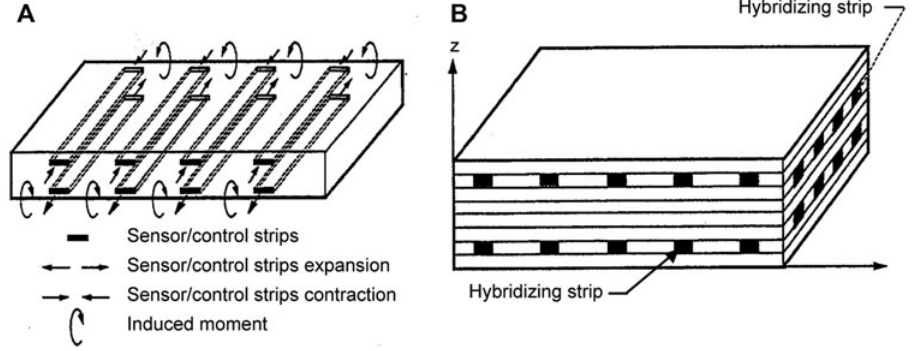
Figure 3 Adaptation of intraply hybrid to smart composite system. (A) Intraply hybrid composite system. (B) Structural control using sensor/ control